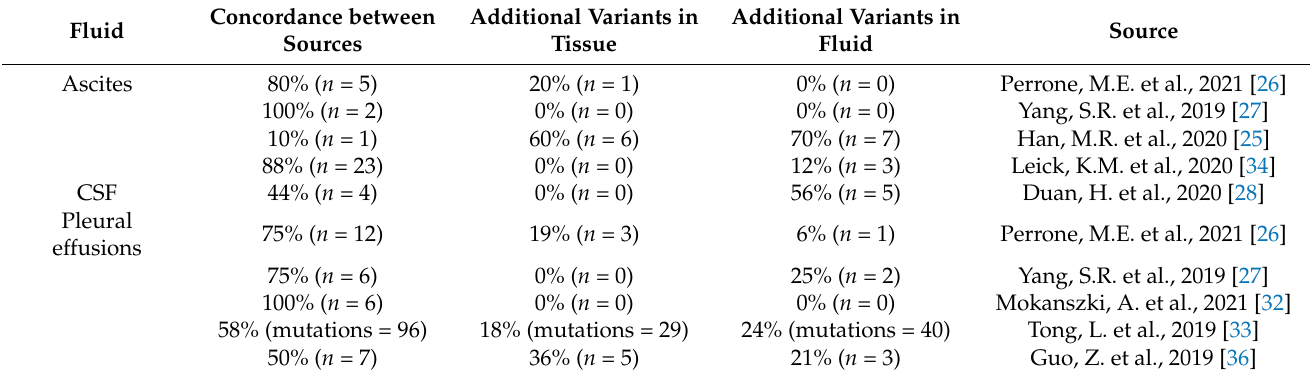
Table 1. Concordance in variants detected in tumour tissue and cfDNA from body